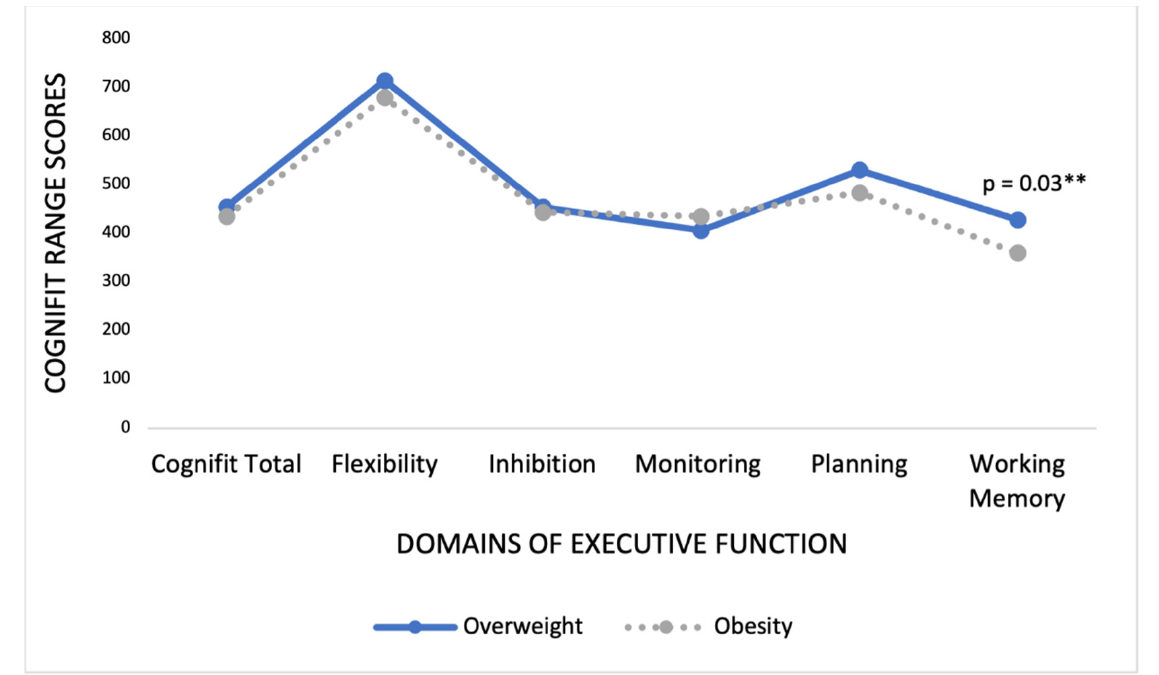
Figure 1. Differences in CogniFit scores between individuals with overweight and obesity. ** p < 0.001. Table 4. Associations of executive function and markers of